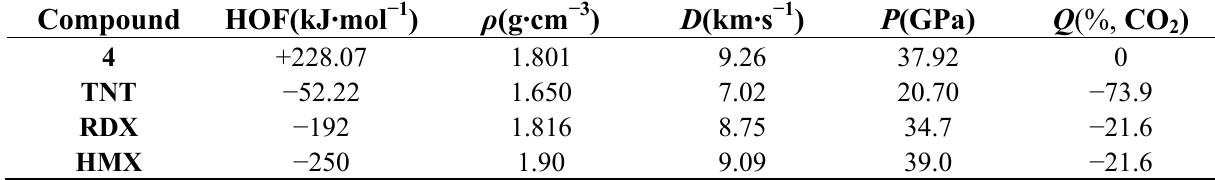
Table 3. The comparison of some properties of compound 4 , TNT, RDX and HMX